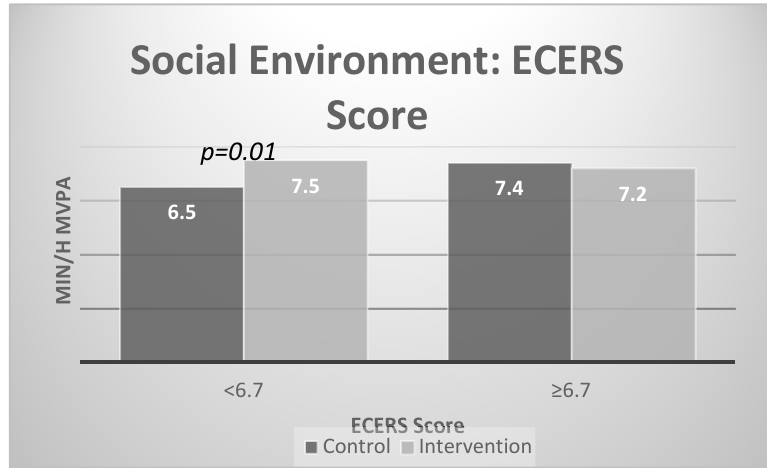
Figure 3. Interaction effects with social environment based on the Early Childhood Environment Rating Scale-Revised Edition (ECERS-R) scale subset.